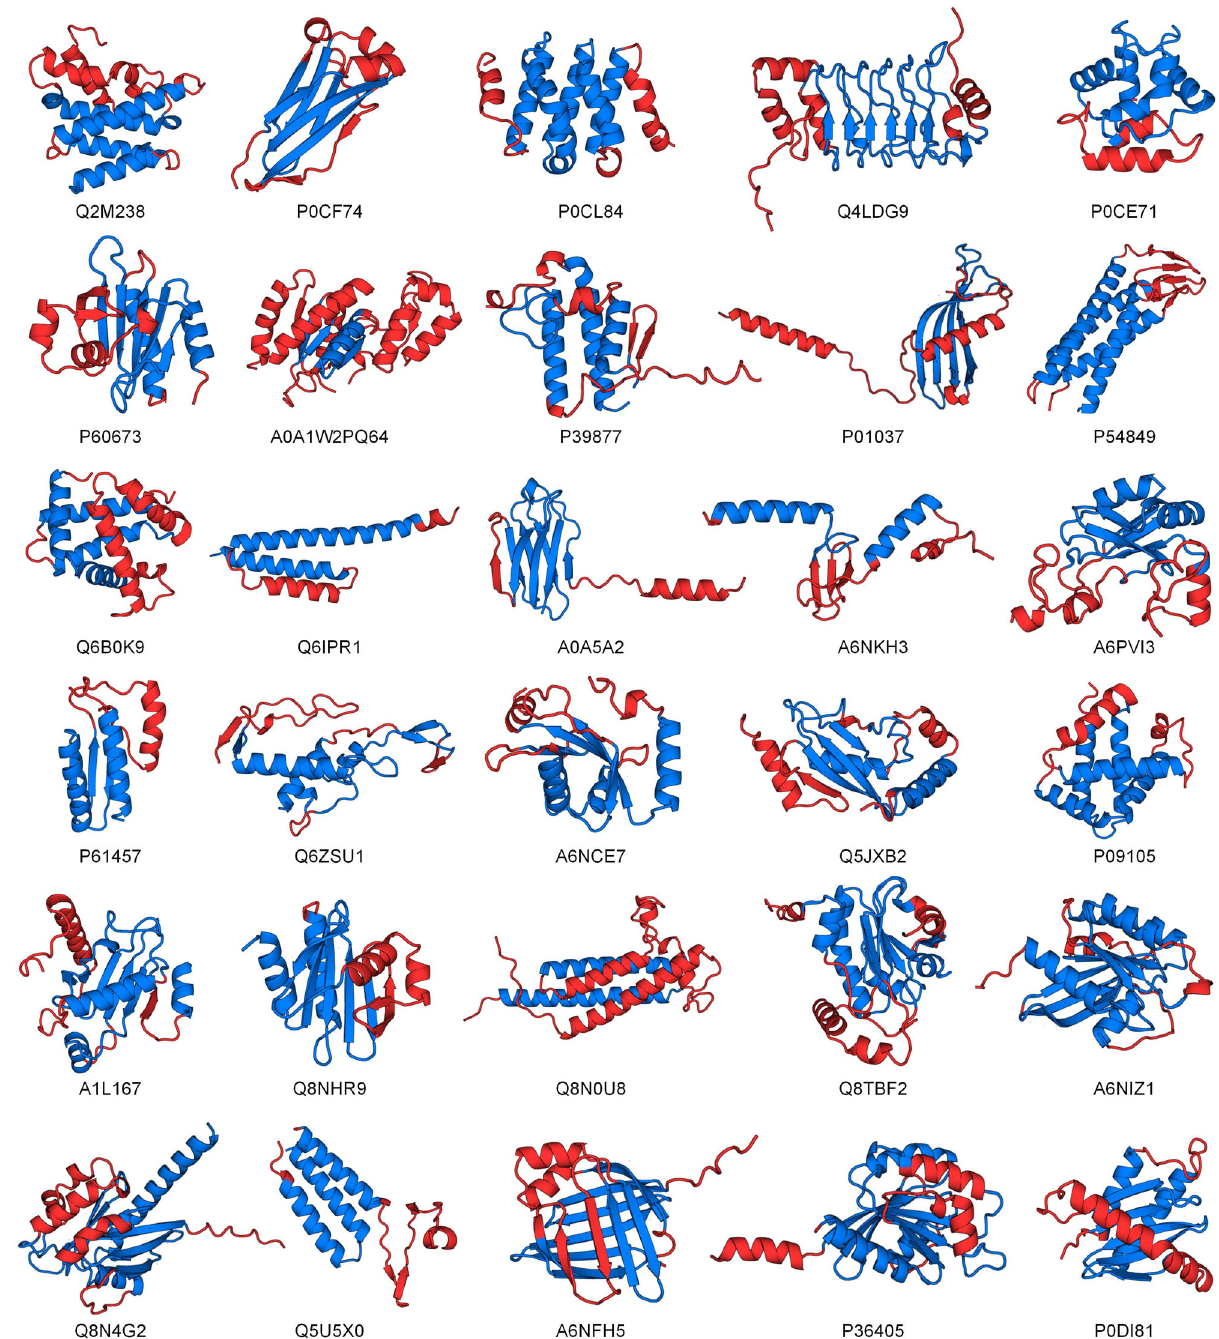
Fig. 7 Results of folding pathways predicted by PAthreader on 30 human proteins. Thirty human proteins, whose native structures have not been determined by biological experiments are labeled with their UniProt accession. The structures shown are identi fi ed by template recognition. The blue region is the intermediate, and the folding order is blue and then